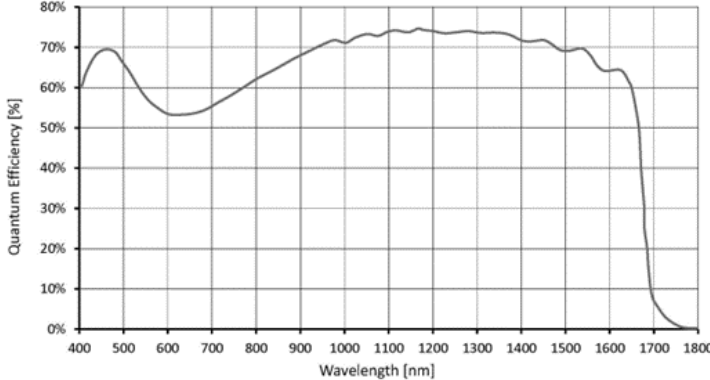
Figure 3. Quantum efficiency of InGaAs detectors adapted to this paper [10].